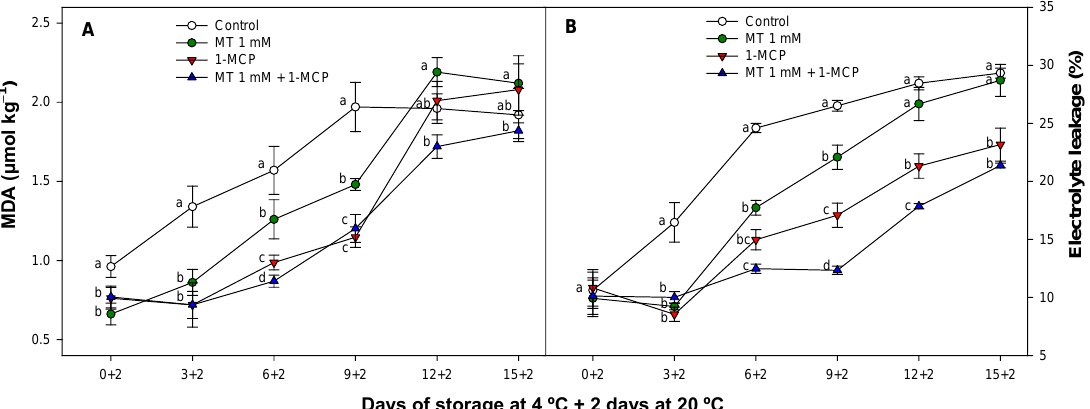
Figure 4. Evolution of malondialdehyde (MDA) content (µmol kg − 1 ) ( A ) an electron leakage (EL) (%) ( B ) of ‘Cronos’ zucchini fruit treated with melatonin at 1 mM (MT) or distilled water (Control) with or without 1-MCP during cold storage and after cold storage plus 2 days at 20 °C. Data are the mean ± SE (n = 3). Different lowercase letters show significant differences ( p < 0.05) among treatments for each sampling date.